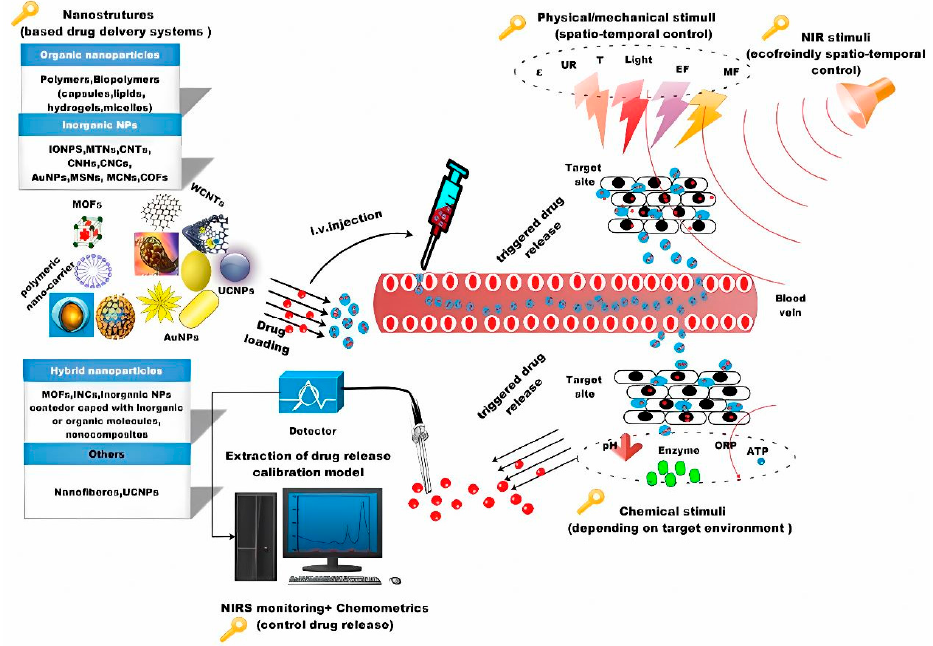
Figure 1. Basic nanostructures for DDSs and different stimuli. Reprinted with permission from Ref. [21].